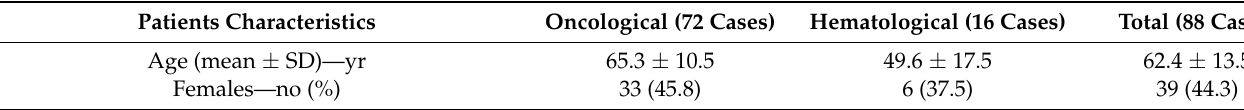
Table 1. Patients’